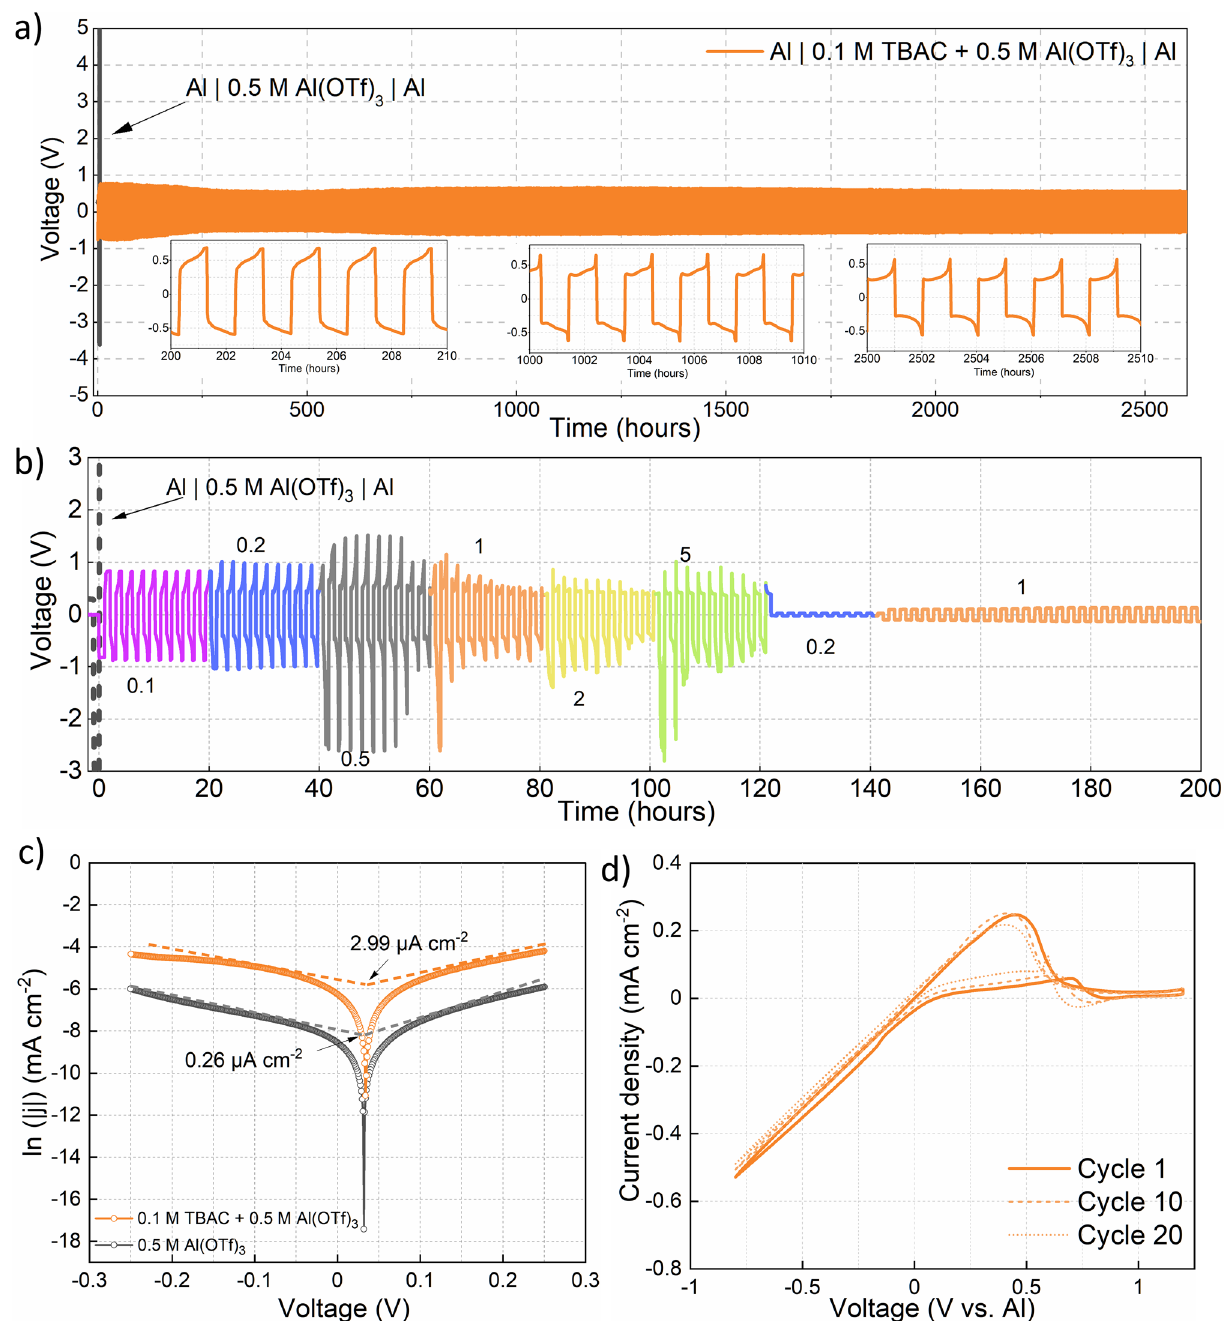
Fig. 1 Comparative plating/stripping study in 0.5 M Al(OTf) 3 vs. 0.5 M Al(OTf) 3 + 0.1 M TBAC at: a 0.1 mA cm −2 , 0.1 mAh cm −2 and b multiple current density, x , as indicated in Fig. ( x mA cm −2 , x mAh cm −2 ). c Tafel curves and corresponding exchange current densities from the linear sweep voltammetry studies (−0.25 to 0.25 V at 1 mV s −1 ) in two electrolytes, 0.5 M Al(OTf) 3 and 0.5 M Al(OTf) 3 + 0.1 M TBAC. d CV scan at 20 mV s −1 in 0.5 M Al(OTf) 3 + 0.1 M TBAC electrolyte with Pt as working electrode, and Al as counter- and pseudoreference